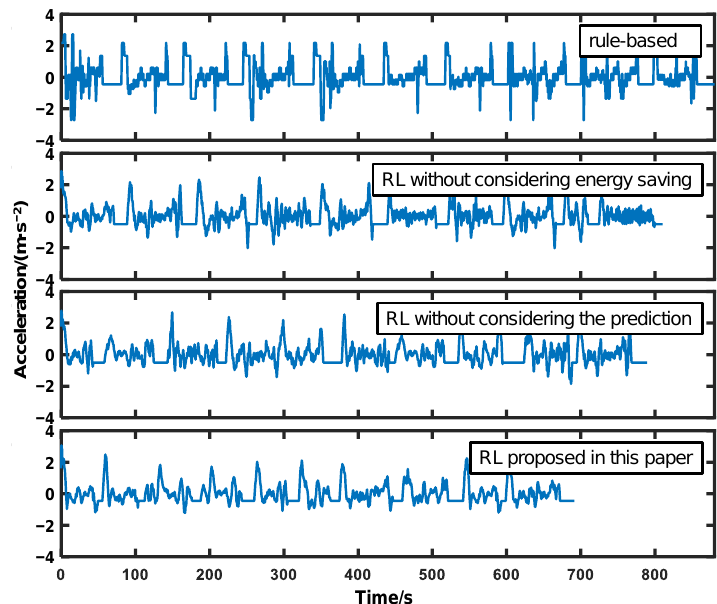
Figure 14. Acceleration profile